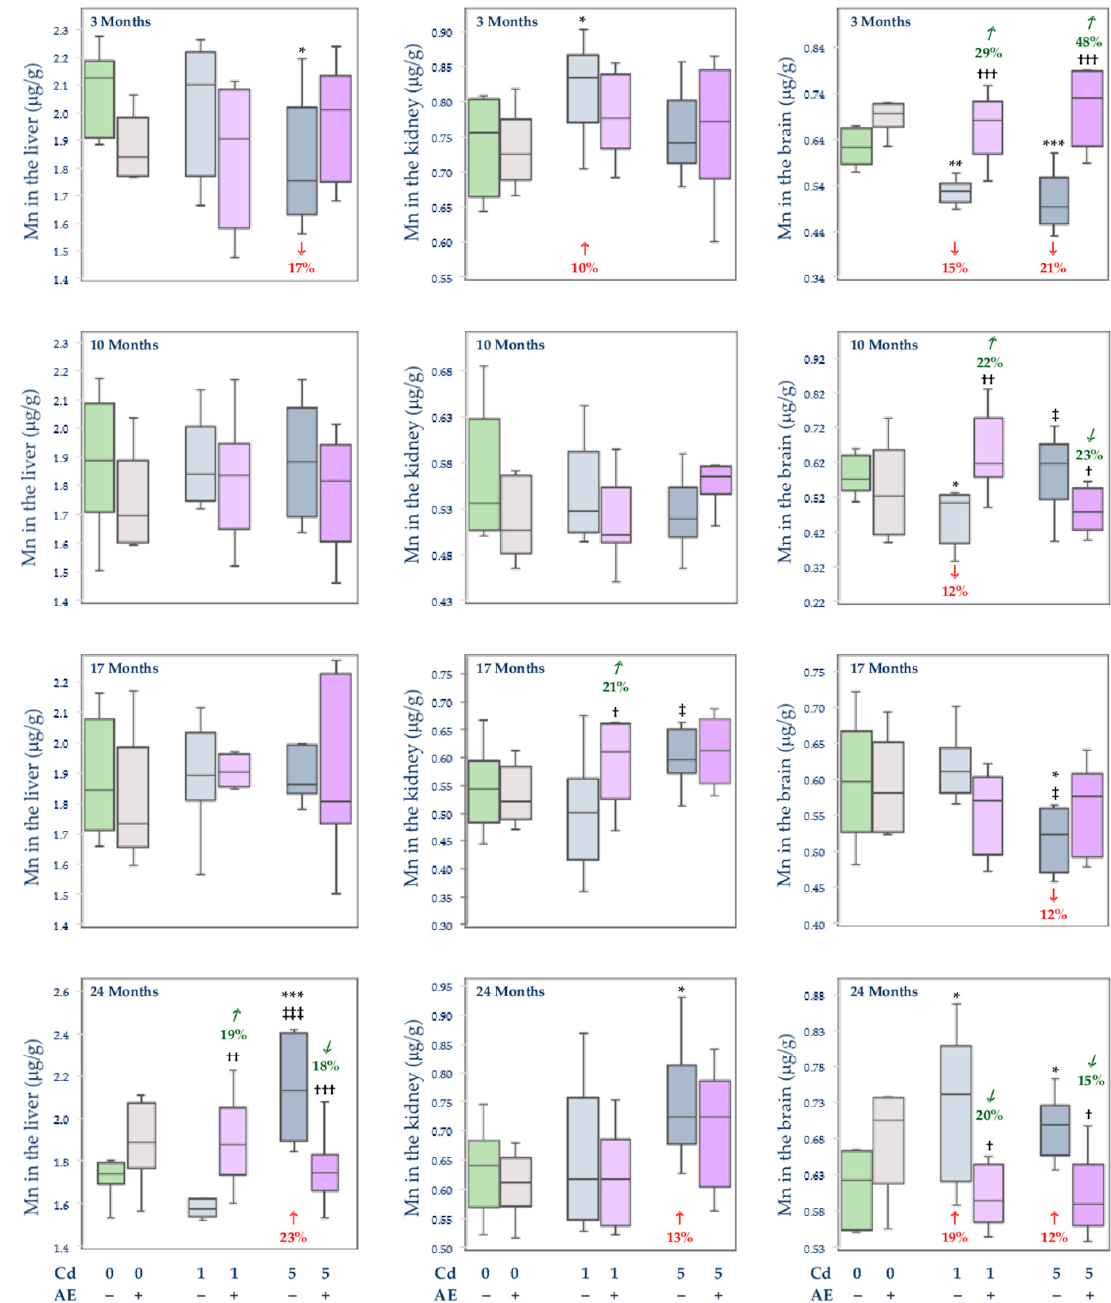
Figure 4. The concentration of Mn in the liver, kidney, and brain in particular experimental groups. The rats received Cd in the diet at the concentration of 0, 1, and 5 mg/kg and/or 0.1% AE as the only drinking fluid (“+”, administered; “ − ”, without administration). Data represent a median and 25–75% confidence interval (the horizontal lines within the bars presenting the confidence interval represent median values), as well as the minimum and maximum values for eight rats in each experimental group (except for seven animals in the AE, Cd1, and Cd5 groups after 24 months). Statistically significant differences: * p < 0.05, ** p < 0.01, *** p < 0.001 vs. control group; † p < 0.05, †† p < 0.01, ††† p < 0.001 vs. respective group receiving Cd alone (Cd1 or Cd5 group); ‡ p < 0.05, ‡‡‡ p < 0.001 vs. respective group receiving the 1 mg Cd/kg diet alone (Cd1 group) or with the AE (Cd1 + AE group) are marked. The values below and above the bars indicate percentage changes compared to the control group ( ↓ , decrease; ↑ , increase) or the respective group receiving Cd alone ( increase),